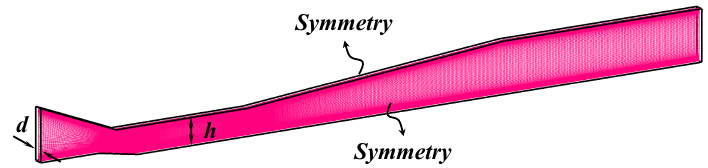
Figure 6. Mesh of the quasi-3D computational domain.